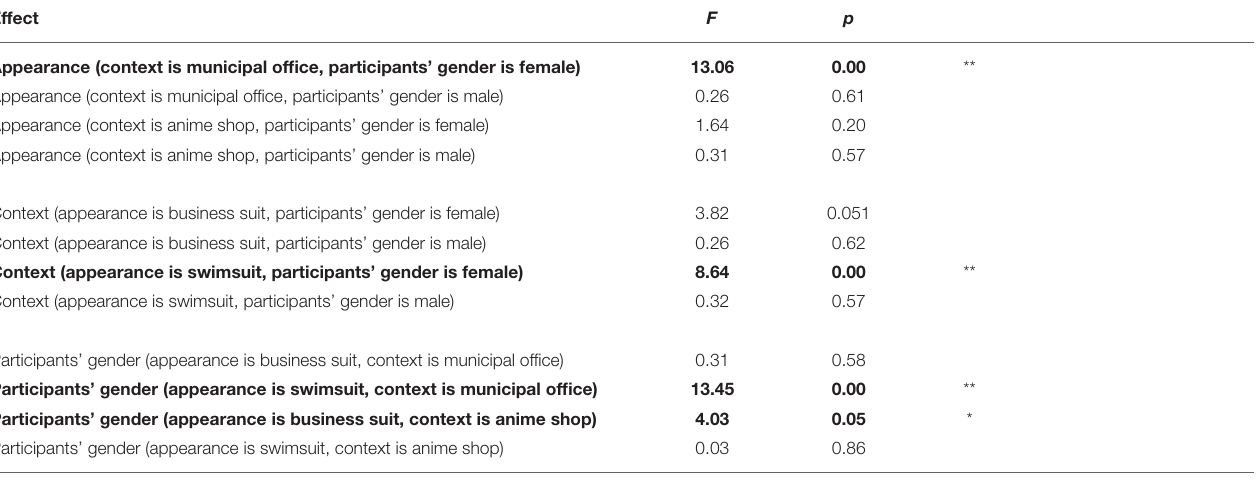
TABLE 6 | Simple main effect test for appearance × context × participants’ gender for Q2 (familiarity). Effect F p